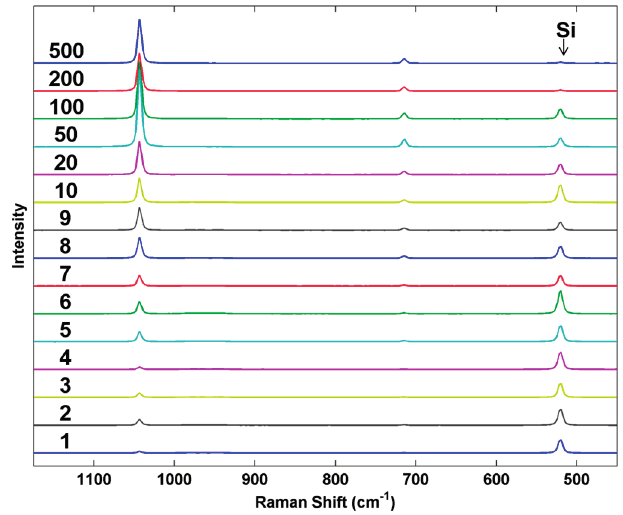
Figure 10. Average Raman spectra from 30 scans taken near the center of each particle from the AN series. Numbers on the left indicate the drops per spot used to create each analyzed particle. For smaller spot sizes ( ≤ 10 drops), spectra were collected over the entire